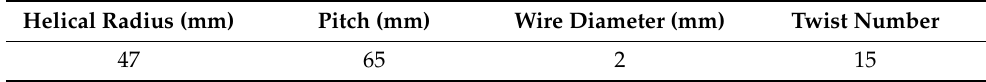
Figure 5. Helical antenna. Table 1. The parameter of helical